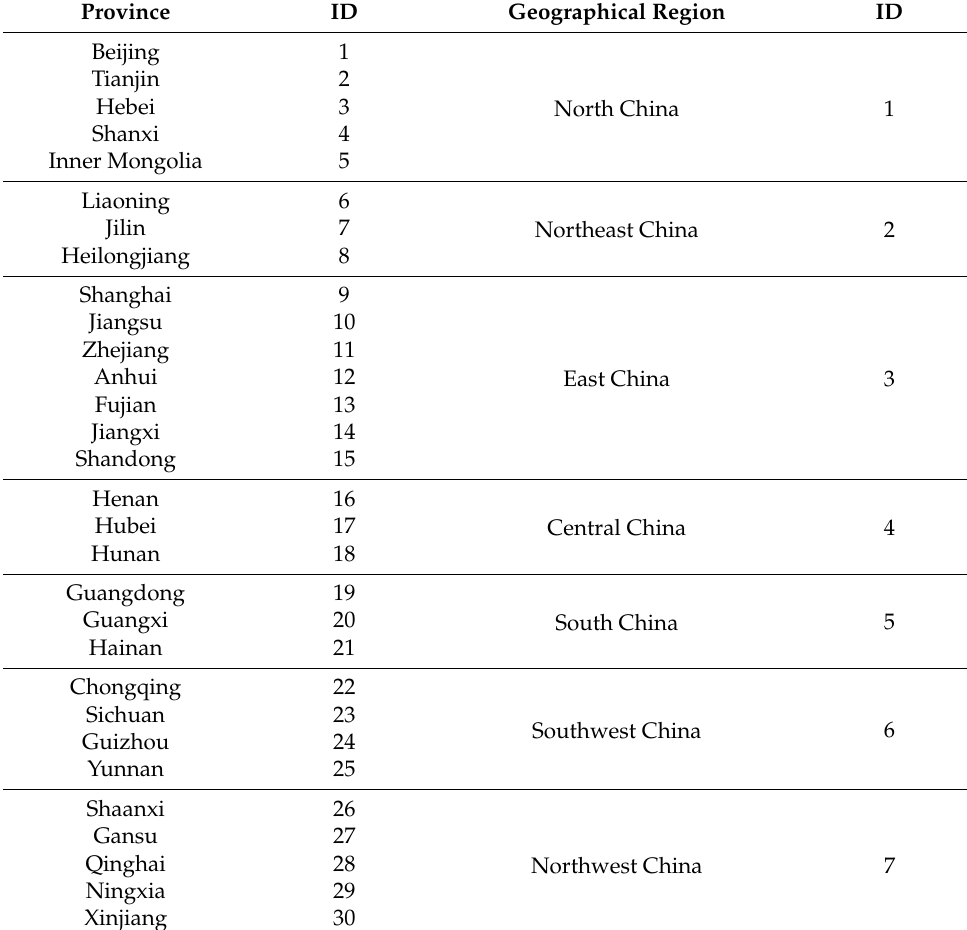
Table 1. The detailed information of the provinces and geographical regions included in the study area. Province ID Geographical Region ID Beijing 1 1Tianjin 2 Hebei